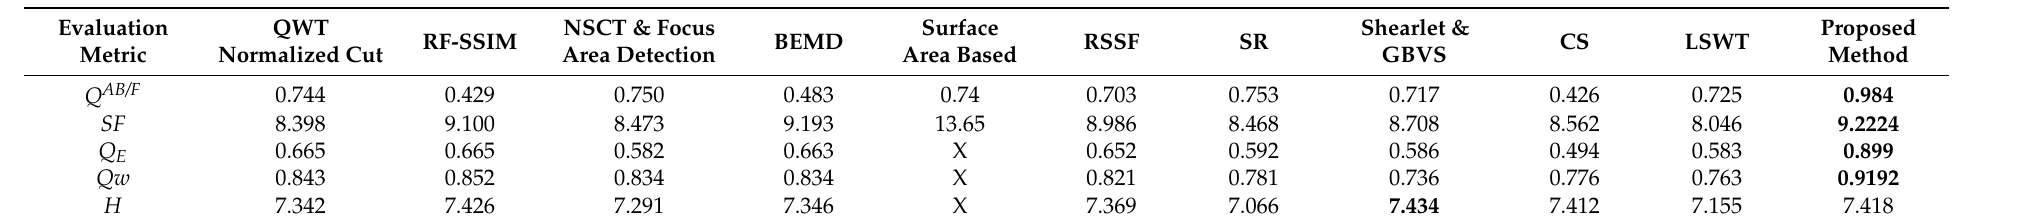
Table 4. The outcomes for the clock image and comparisons with existing techniques in the literature ([22]). Evaluation Metric